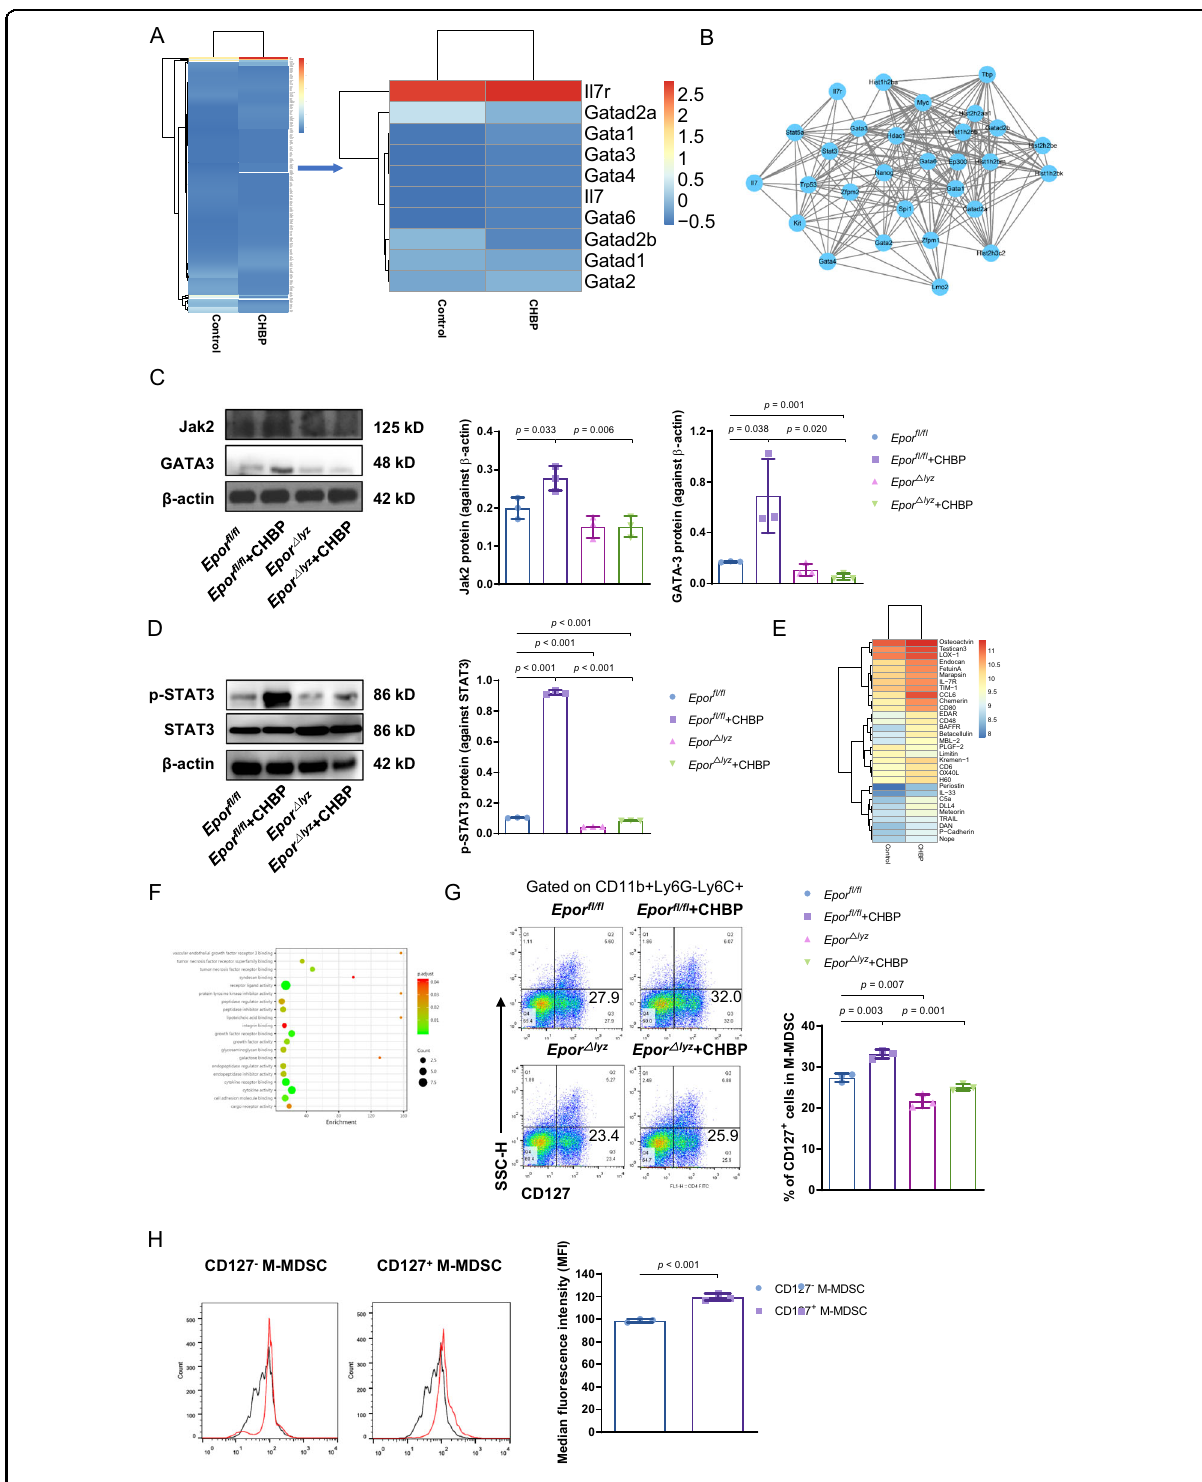
Fig. 5 CD127 + M-MDSCs induced by CHBP exerted stronger immunosuppressive function. A RNA-seq detected the different RNA expressions in M-MDSCs with or without CHBP treatment in vitro. B The String analysis of mRNA sequencing. C The Jak2 and GATA3 protein expression by western blot. D The p-STAT3 and STAT3 protein expression by western blot. E Protein array compared the difference in M-MDSCs with or without CHBP treatment in vitro. F The molecular function enrichment of protein array. G Detection and quanti fi cation of the CD127-positive cells in M-MDSCs by fl ow cytometry. H T-cell proliferation detected by CFSE. The ratio of G-MDSCs and T cells was